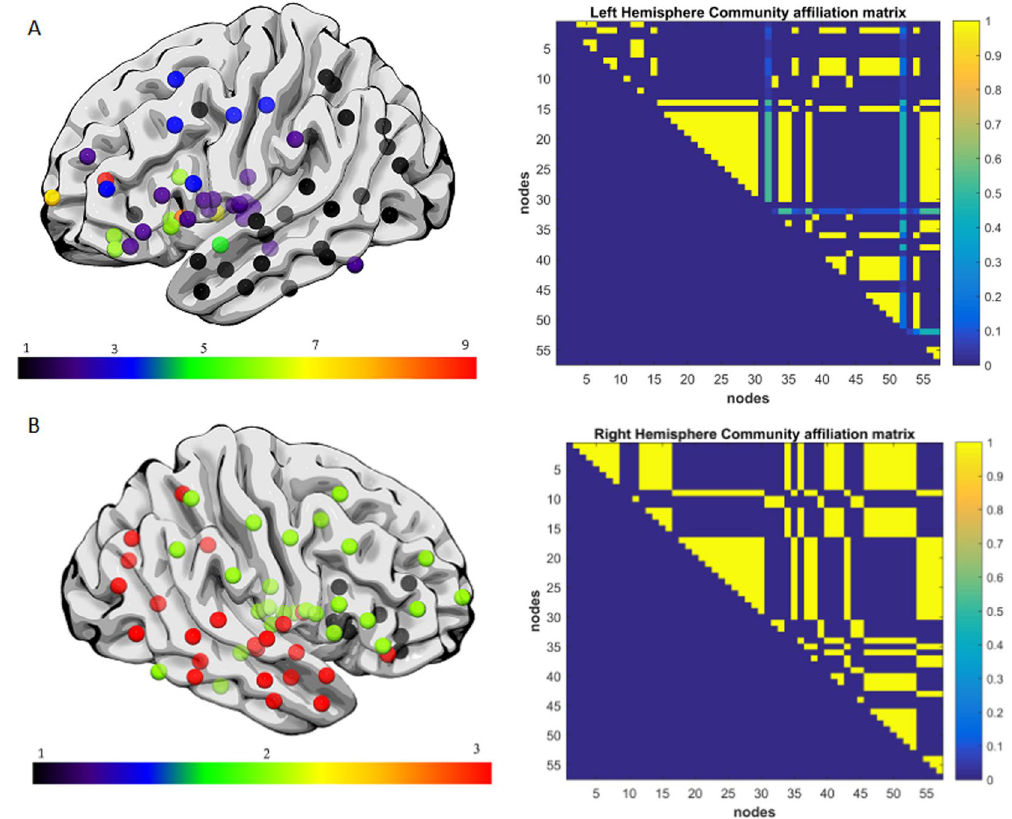
Figure 8. ( A ) Exemplar data Subject 4, each color represents a single community left hemisphere lateral view. Note the fragmentation of the fronto-parietal, inferior frontal and middle-temporal networks with the hemisphere grouping into 9 modules. Subject 4 had a lesion volume of 206.36 cm 3 , percent white matter damage of 0.035, and a WAB-AQ score of 41.8. Note the missing nodes and unstable clustering in the community affiliation matrix. ( B ) Exemplar data Subject 4, right hemisphere lateral view, each color represents a single community. There was no apparent fragmentation, and the network was divided into 3 communities. The community affiliation matrix also showed stable clustering over 100